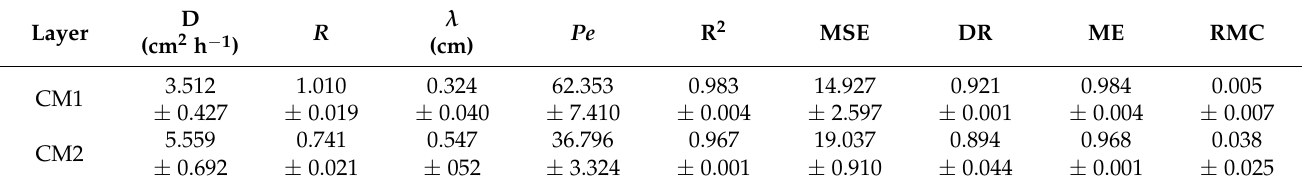
Table 5. Estimated values of parameters, determination coefficient R 2 , and statistical criteria for the CDE model for KBr transfer in the soils CM1 and CM2 for the tracer (KBr).